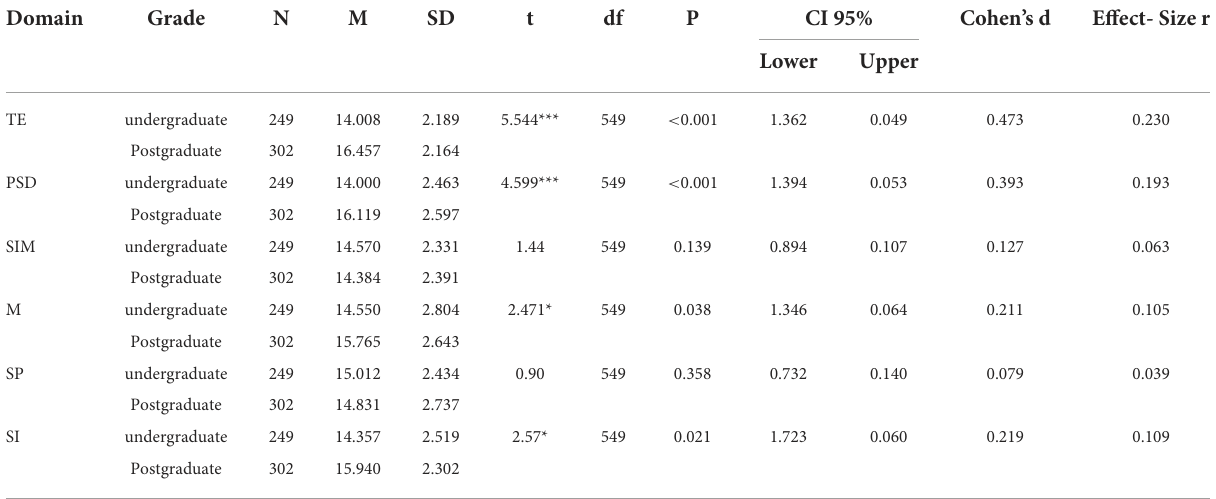
TABLE 4 Effect of grade variable on the academic expectations of